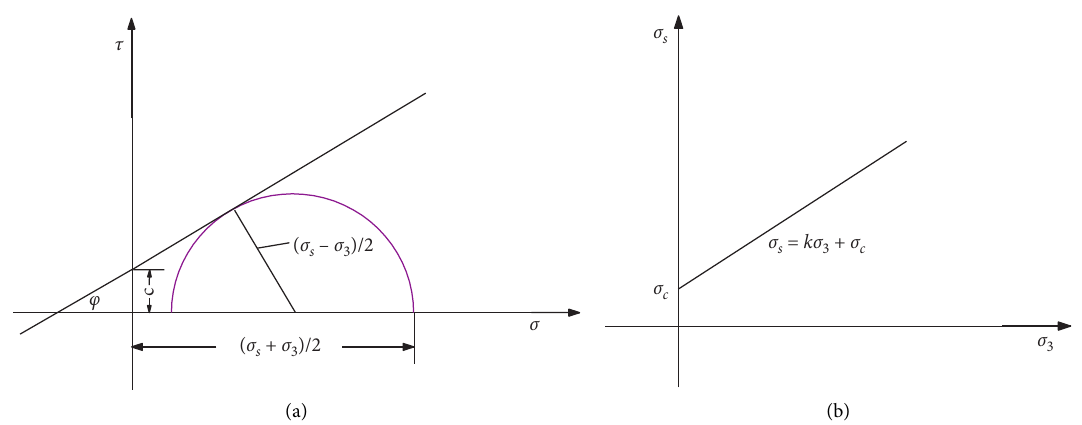
Figure 4: Mohr-Coulomb strength criterion and stress curve at failure. (a) Mohr-Coulomb strength criterion. (b) Stress curve at failure.